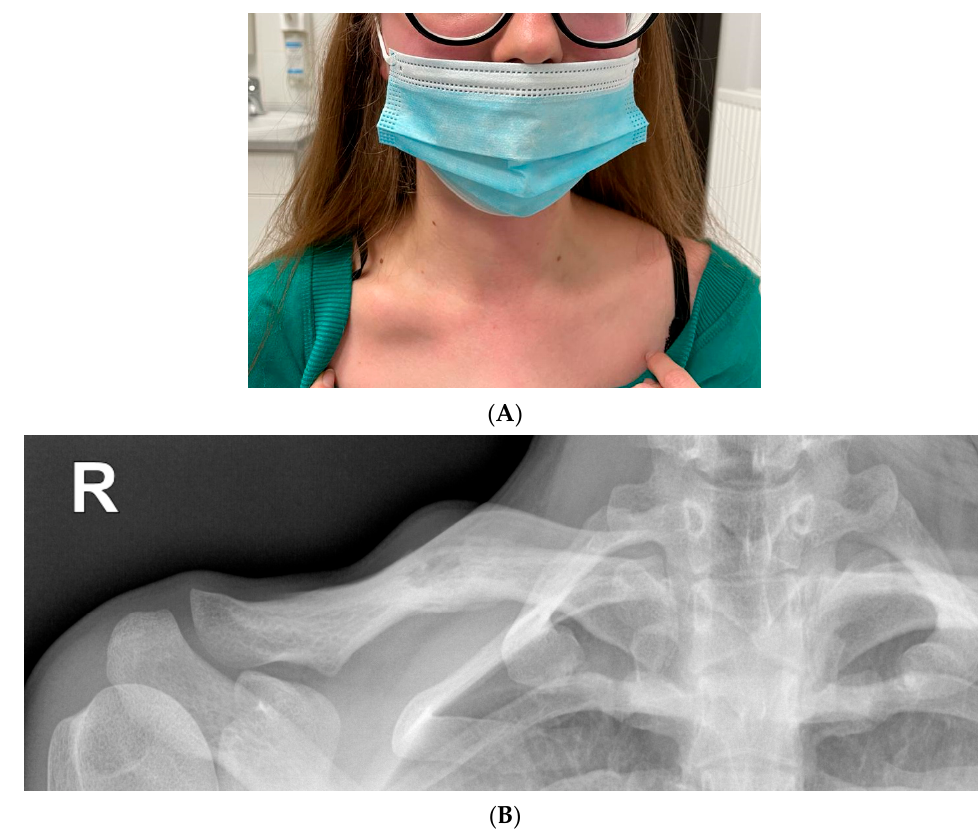
Figure 7. ( A ) Lumpy distension of the right clavicle the size of a quail egg with accompanying palpation tenderness. ( B ) Radiolucency on the right clavicle, probably an osteolytic lesion (15 mm). Linear shading along the bottom edge of the clavicle—periosteal reaction. Extended diagnostics recommended.